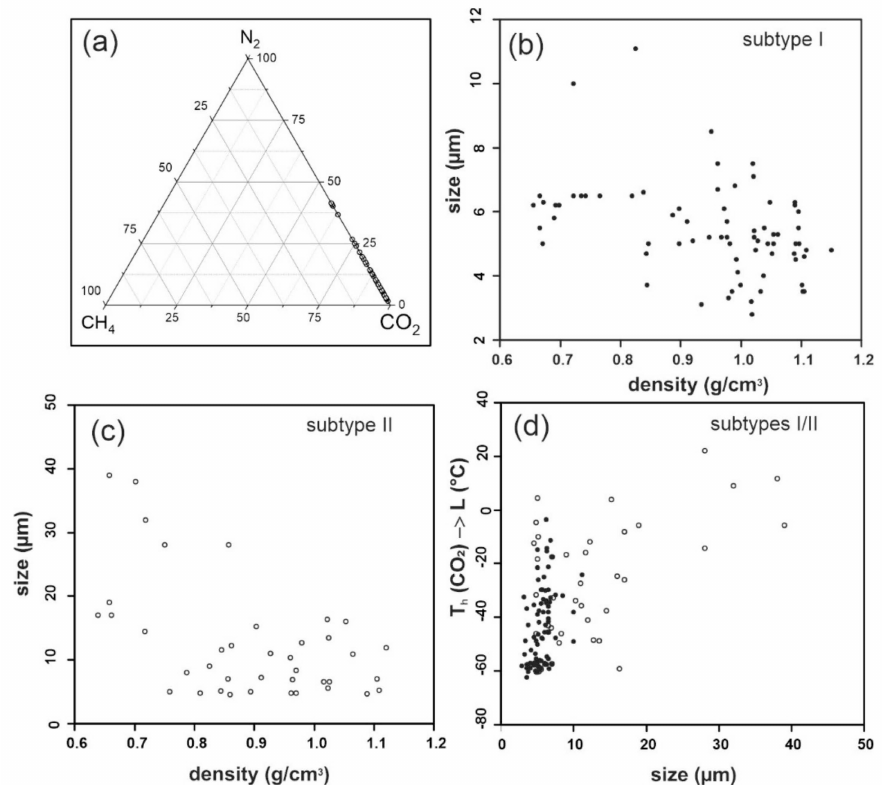
Figure 6. ( a ) Fluid chemistry plotted in a ternary CO 2 -N 2 -CH 4 diagram. Chemistry was calculated from Raman spectra after Equation (2) in Burke [31]. ( b ) Size versus density of subtype I FIs. ( c ) Size versus density of subtype II FIs. ( d ) Homogenization temperatures versus size of subtypes I and II FIs (subtype I: black circles; subtype II: open